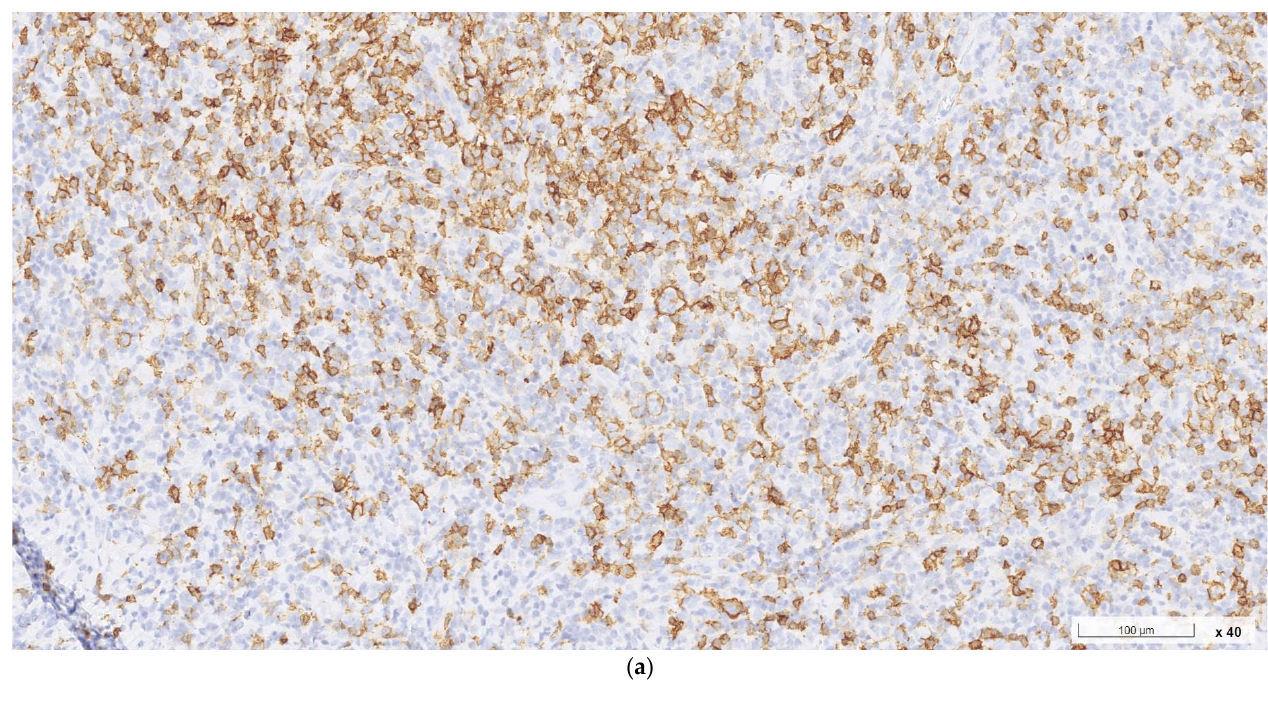
Figure 2. Histopathological examination of enlarged right cervical lymph node; obtained from his previous healthcare provider. ( a – c ): Hematoxylin–eosin staining demonstrated a thick fibrous capsule, focal nodular sclerosis, near-total nodal structure effacement, and increased vascularity. Scattered Hodgkin-like and Reed–Sternberg-like cells were seen in the background of small lymphocytes, plasma cells, neutrophils, histiocytes, and an excess of eosinophils.